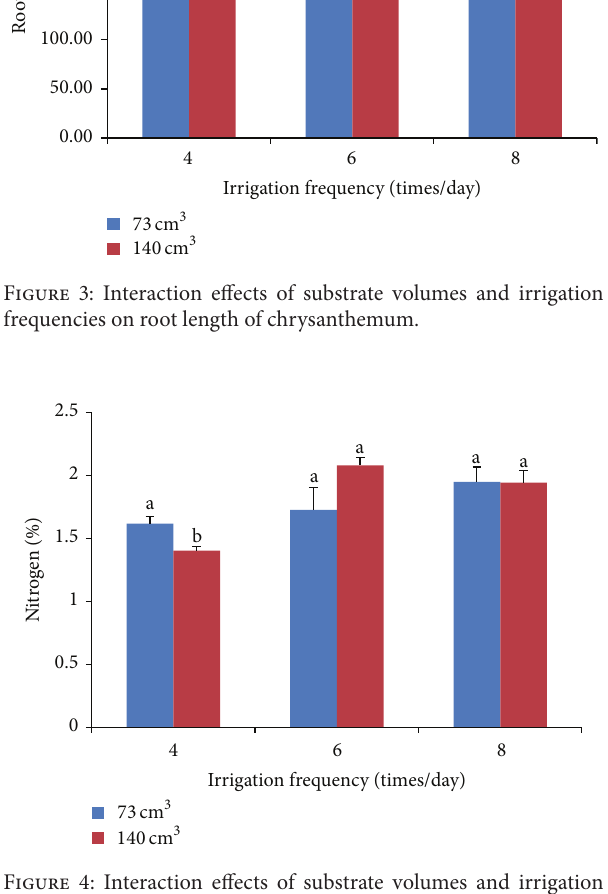
Figure 4: Interaction effects of substrate volumes and irrigation frequencies on nitrogen level of chrysanthemum.